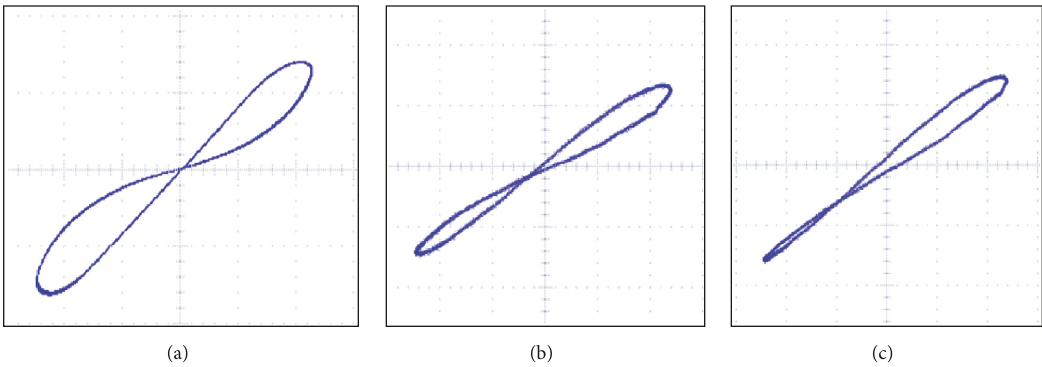
Figure 9: Experimental results of the incremental type emulator when 𝐶 1 = 𝐶 2 = 100 pF. (a), (b), and (c) represent hysteresis loops in V - 𝑖 plane operating at 10 kHz, 35 kHz, and 50 kHz, respectively. The scales are 0.2 V/div for 𝑥 -axis and 0.2 V/div for 𝑦 -axis.